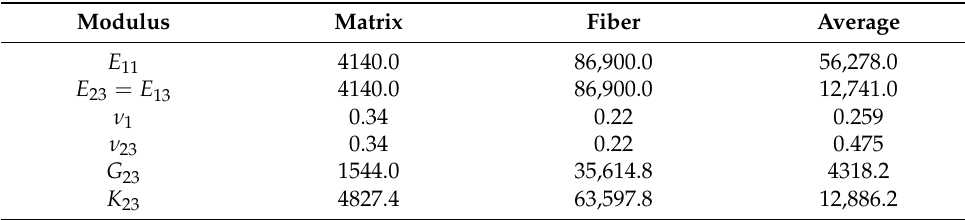
Table 4. Computed values of elastic moduli (Case 2).